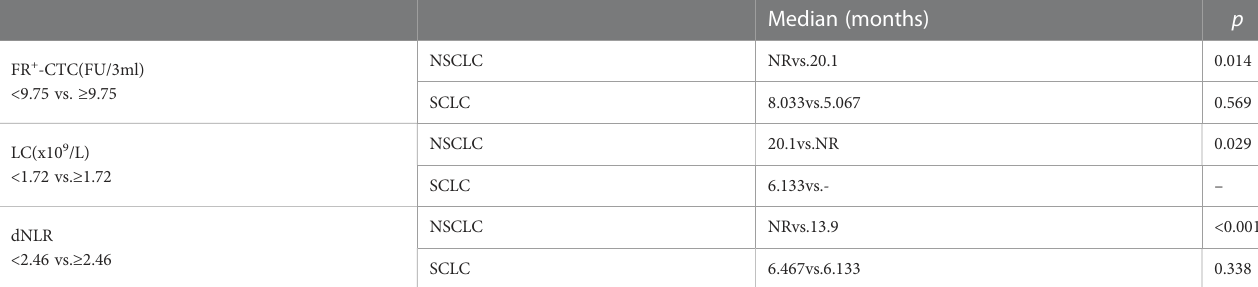
TABLE 4B Survival probability according to the FR+-CTC count, LC and dNLR between NSCLC and SCLC.